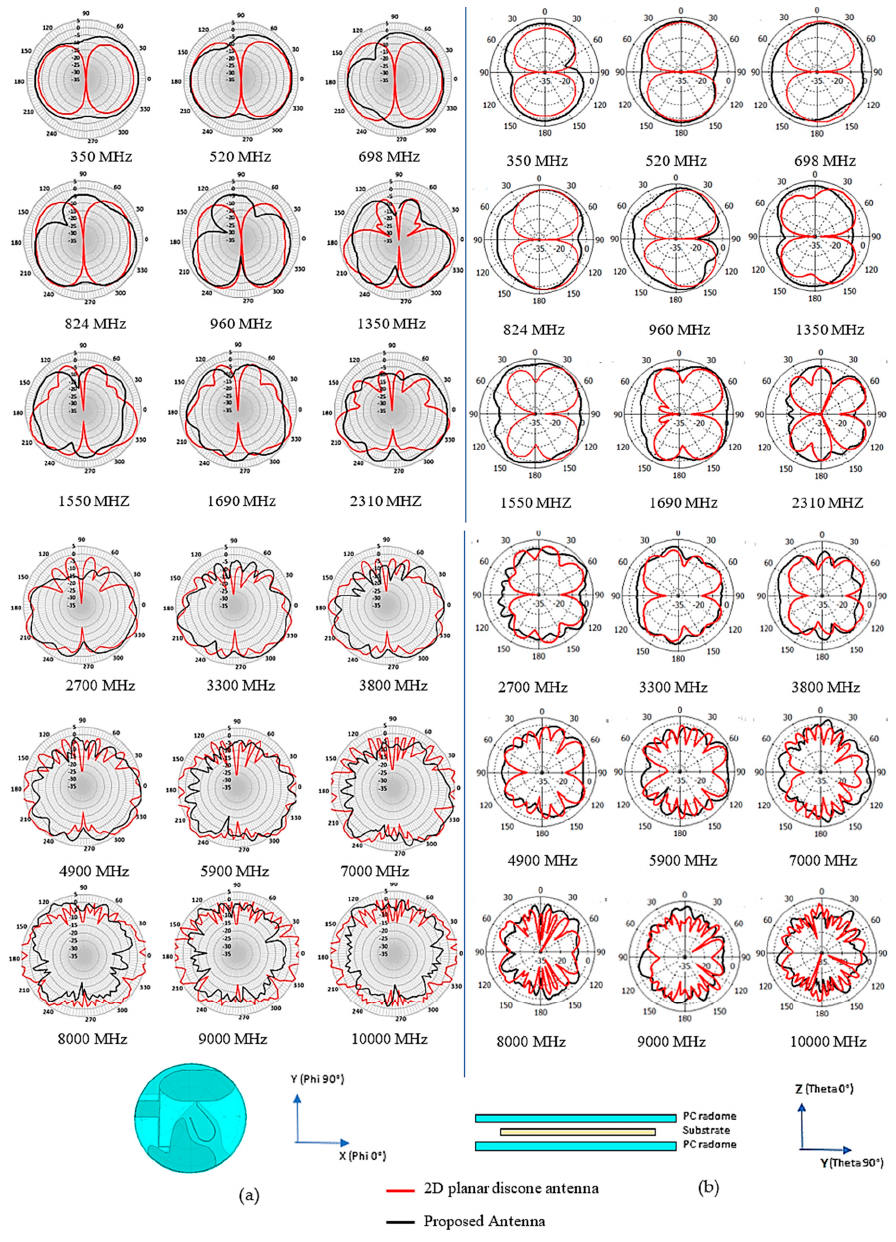
Figure 12. Comparison of the simulated radiation pattern of the conventional 2D planar discone antenna and the proposed antenna at ( a ) Azimuth Plane (X-Y Plane) and ( b ) Elevation 90° Plane (Y-Z Plane).